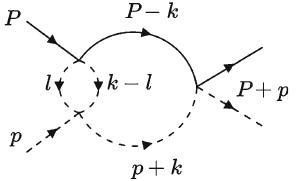
Fig. 9 A two loop fish diagram in π − K